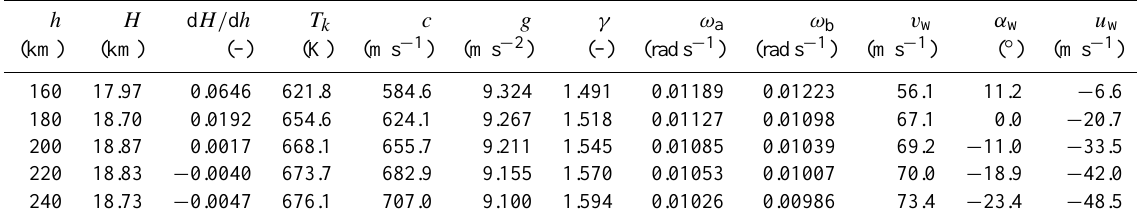
Table 1. The input parameters of Hines’ dispersion equation on 20 January 2010, 10:00UT, above Tromsø, for the specified